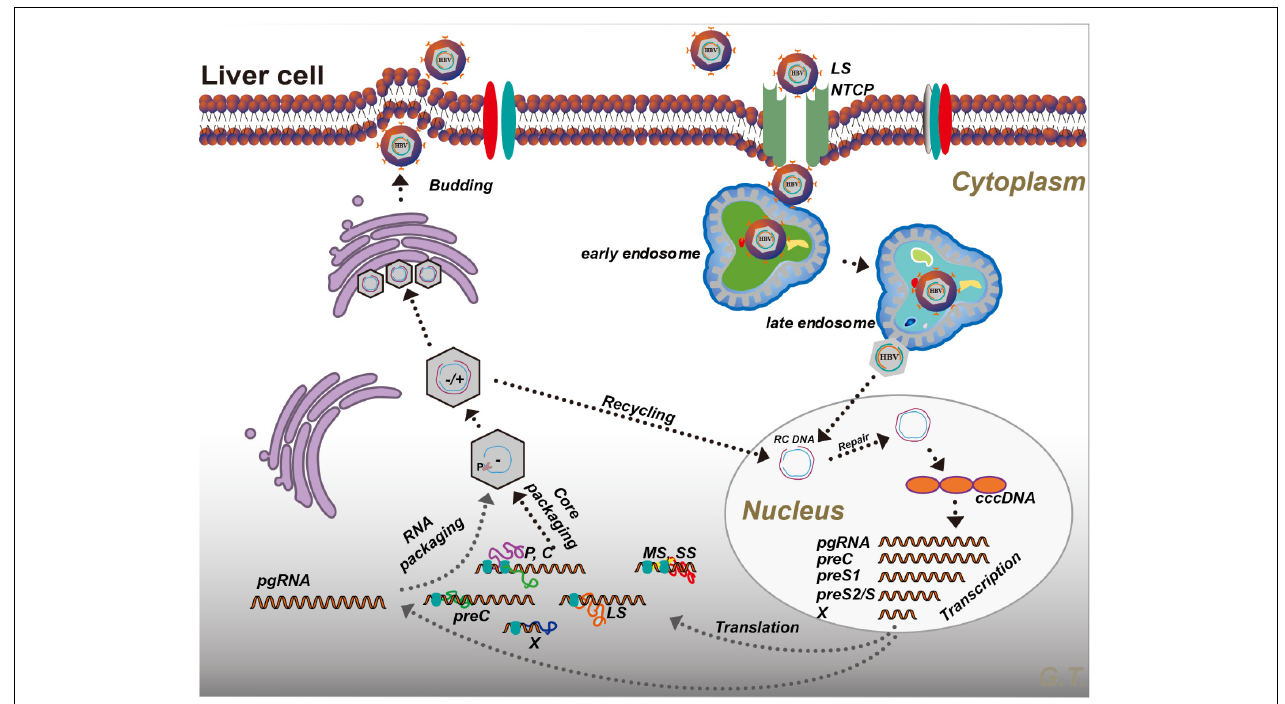
FIGURE 2 | Hepatitis B virus life cycle. Please see the text for details. P, polymerase; LS, large S; MS, middle S; SS, small S; preC, pre-Core; C, core; X, HBx; RC DNA, relaxed circular DNA; NTCP, sodium taurocholate co-transporting polypeptide; cccDNA, covalently closed circular